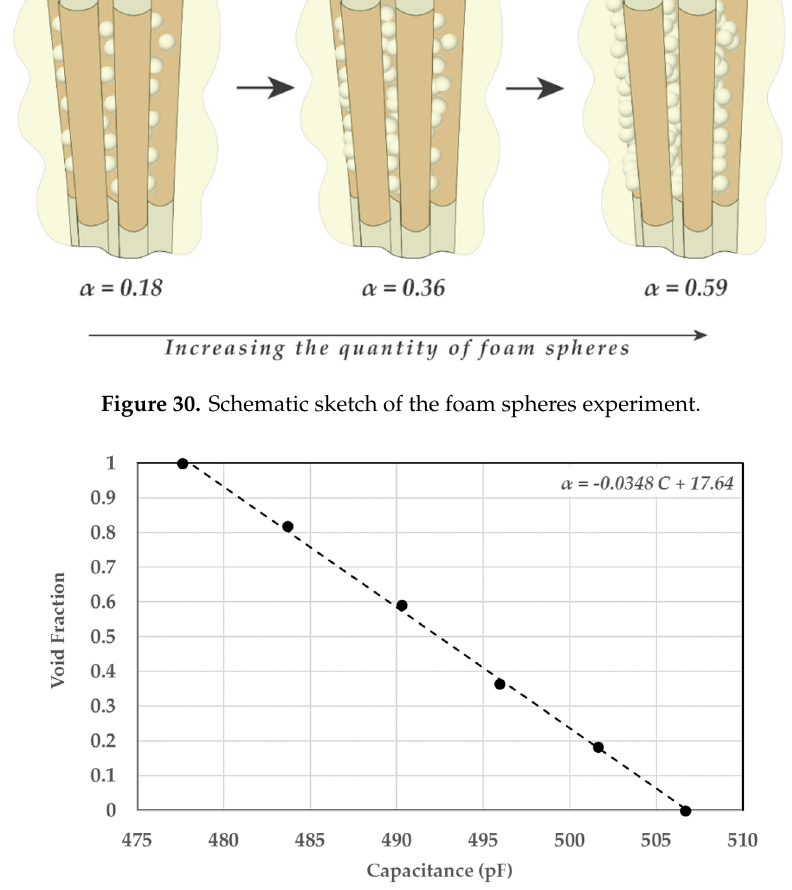
Figure 31. Calibration curve for air–castor oil conditions using foam spheres for the single-sensor configuration.